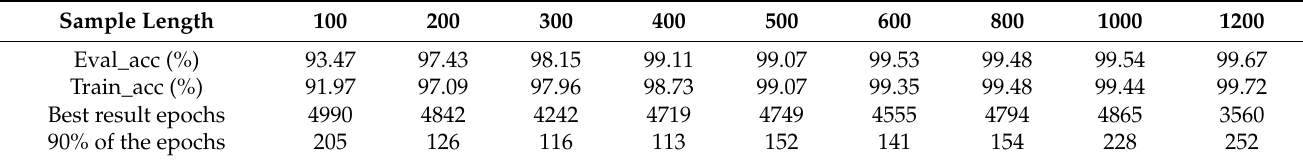
Table 3. Experimental results of MLAT under different sample lengths.